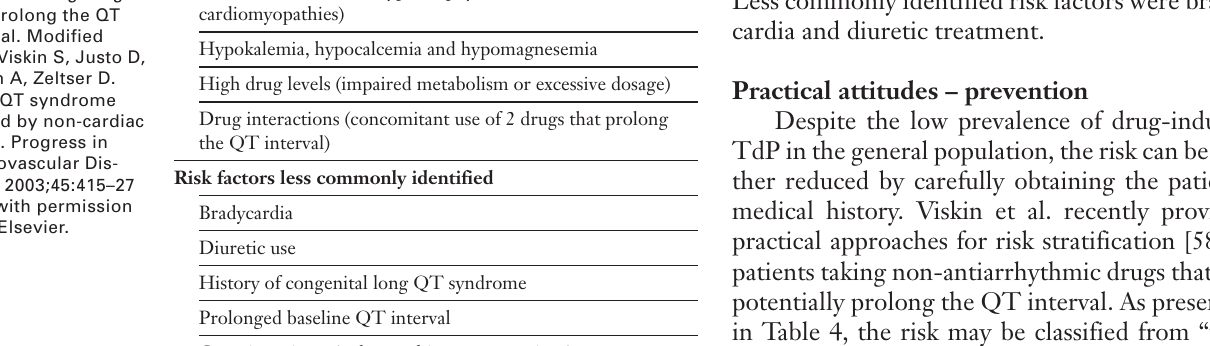
Identified risk factors for developing TdP in patients taking drugs that prolong the QT interval. Modified from Viskin S, Justo D, Halkin A, Zeltser D. Long QT syndrome caused by non-cardiac drugs. Progress